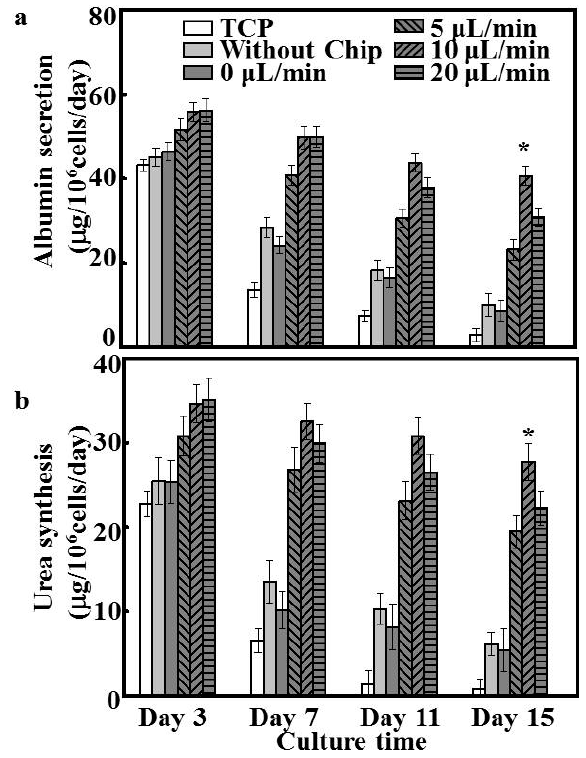
Figure 5. Liver-specific functions of hepatocytes on different substrates during 15 days of culture, including: ( a ) albumin secretion and ( b ) urea synthesis ( n = 5); * p < 0.05. including: ( a ) albumin secretion and ( b ) urea synthesis ( n = 5); * p <